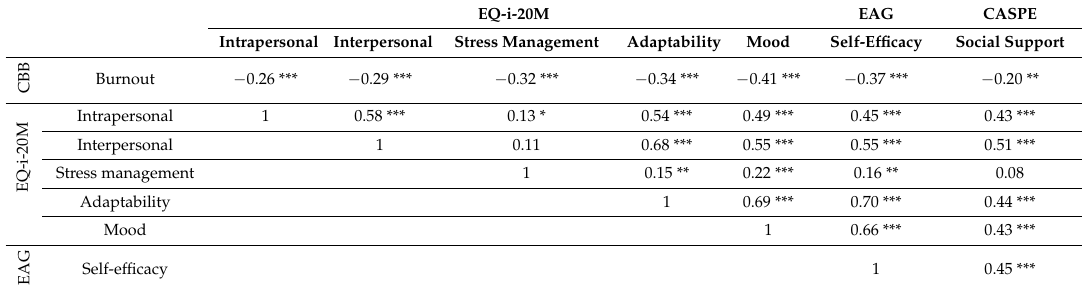
Table 1. Correlations between burnout and emotional intelligence, self-efficacy, and social support variables. EQ-i-20M EAG CASPE Intrapersonal Interpersonal Stress Management